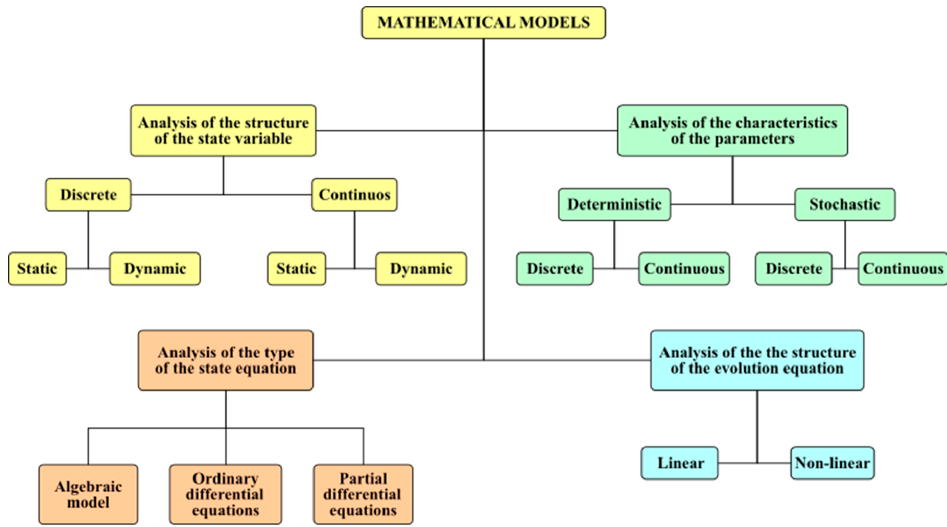
Figure 6. General classification of mathematical models. “Source [11], own elaboration.”.